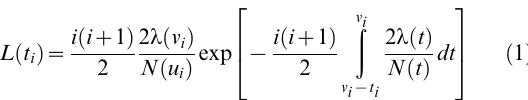
The final column indicates, for each model, the number and percentage of the 289 empirical phylogenies for which the model exhibits the lowest AICc.